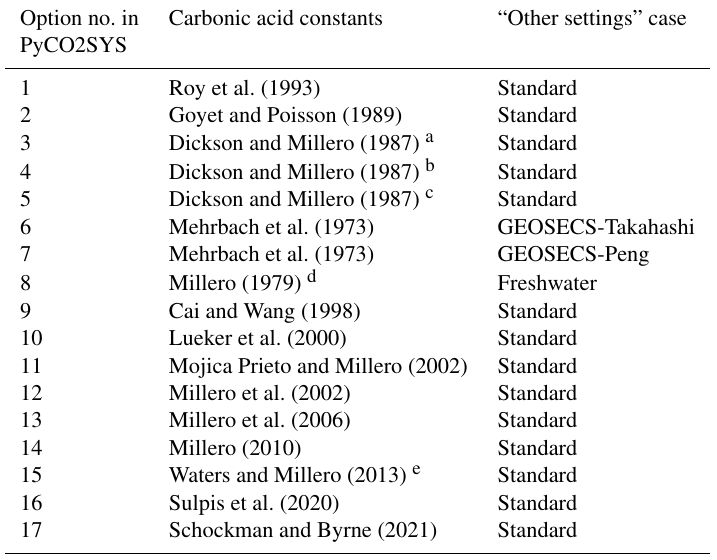
Table 1. Parameterisations of the dissociation constants of carbonic acid available in PyCO2SYS and corresponding implicit settings (Ta- ble